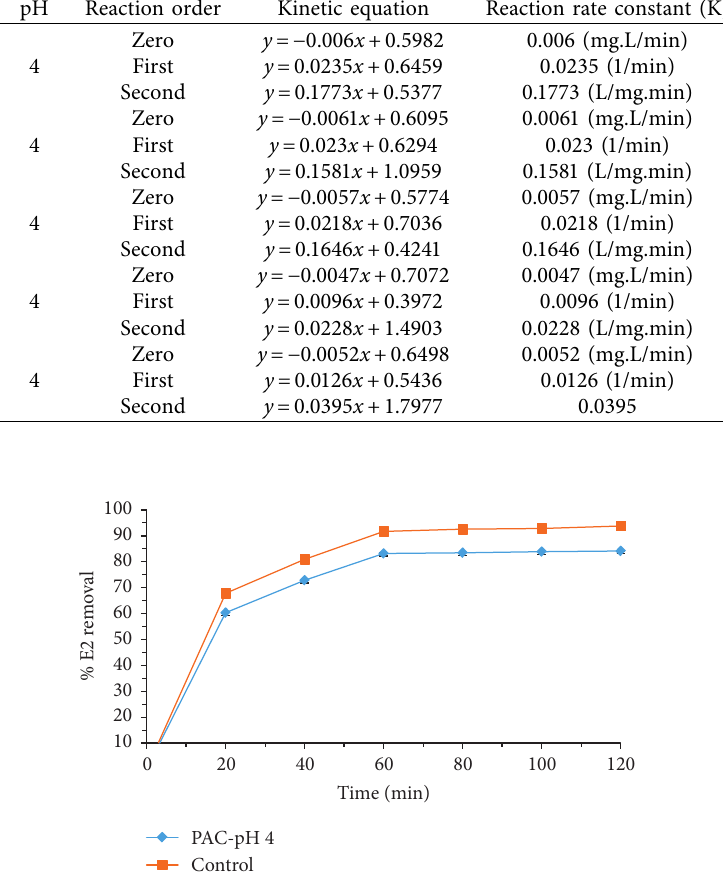
Table 3: Degradation kinetic parameters of E2 in presence of coexisting materials for optimum pH. Steroid estrogen Salt pH Reaction order Kinetic equation